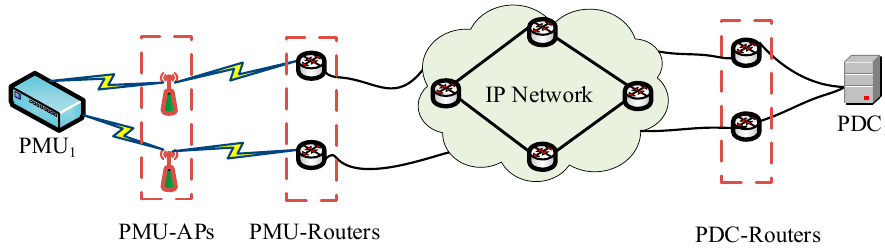
Figure 7. Simplified reliable hybrid SCN.